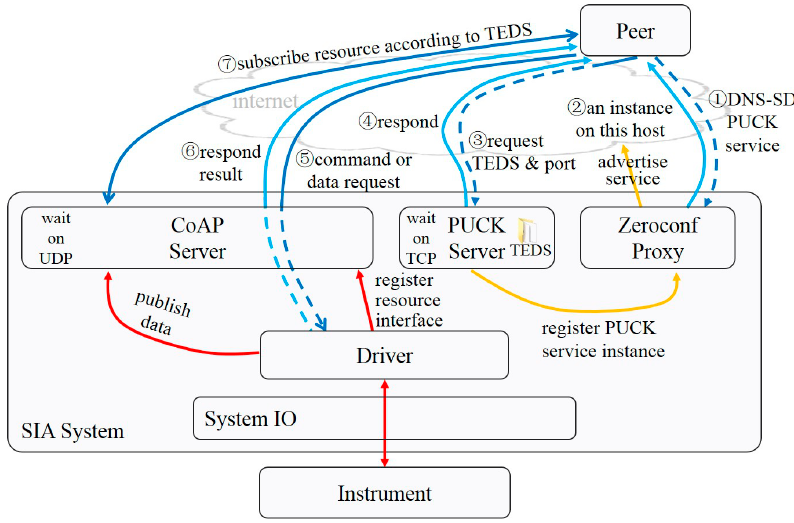
Figure 7. Interoperable communication scheme with no MQTT broker.